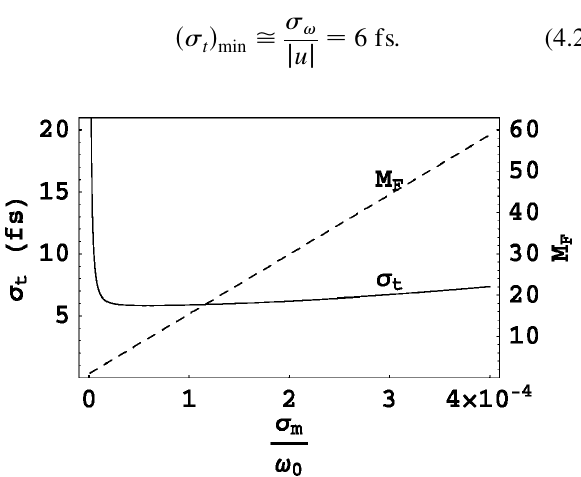
and the t of the radiation after a monochromator F =! for a (full) energy chirp of 1%. The m 0 (cid:1) 5 (cid:4) 10 (cid:5) 4 , which =! ! 0